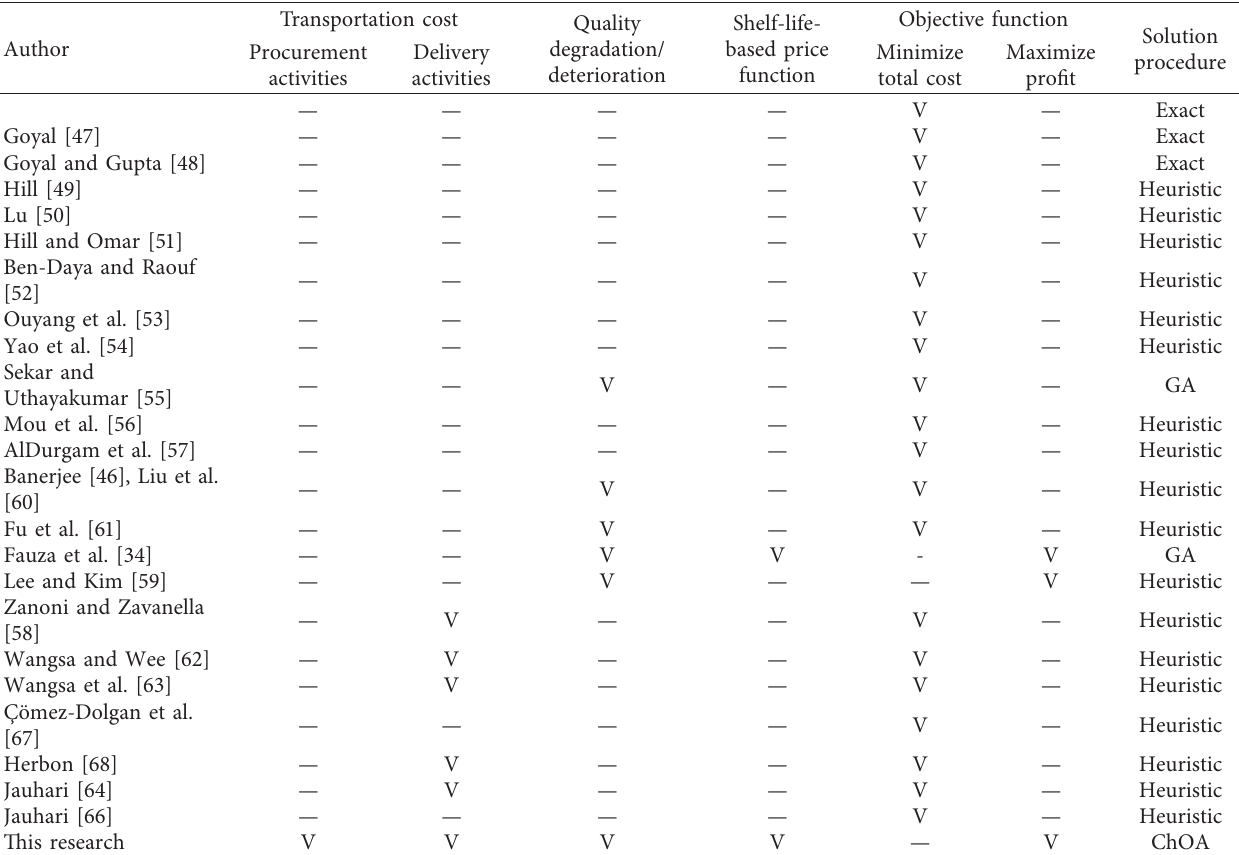
Table 1: Comparison of this study with previous studies in I-SVSB-IP.